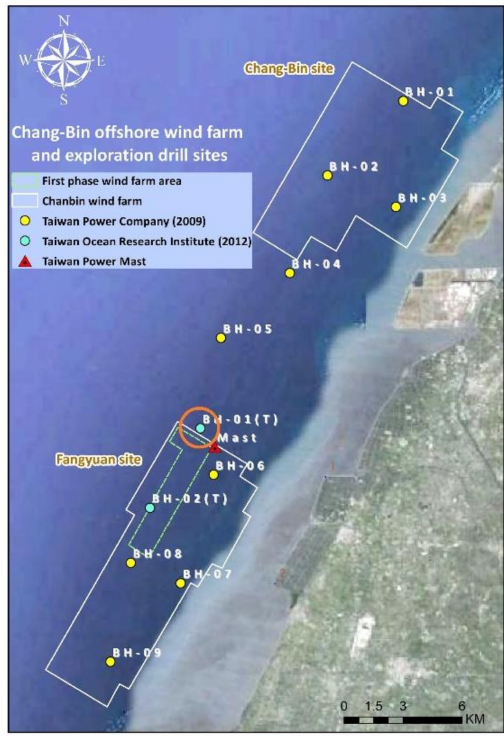
Figure 1. Taiwan Power Company’s (TPC’s) met mast and borehole site at Chang-Bin offshore wind farm.